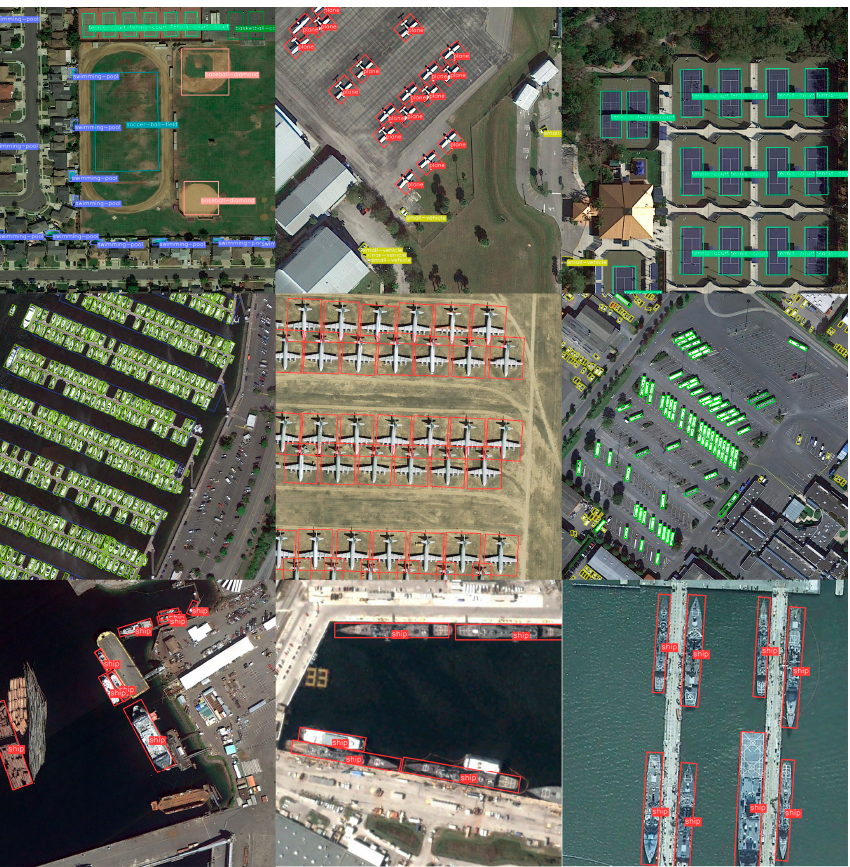
Figure 9. The visualization results on DOTA dataset and HRSC2016 dataset. The first two lines are the DOTA dataset, and the third line is the HRSC2016 dataset.